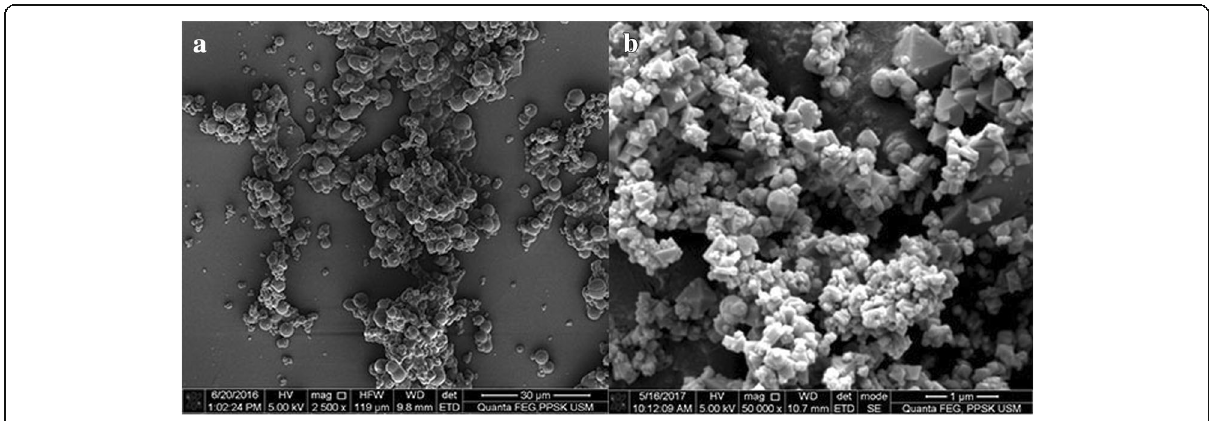
Fig. 1 SEM images of NP ( a ) and BP ( b )